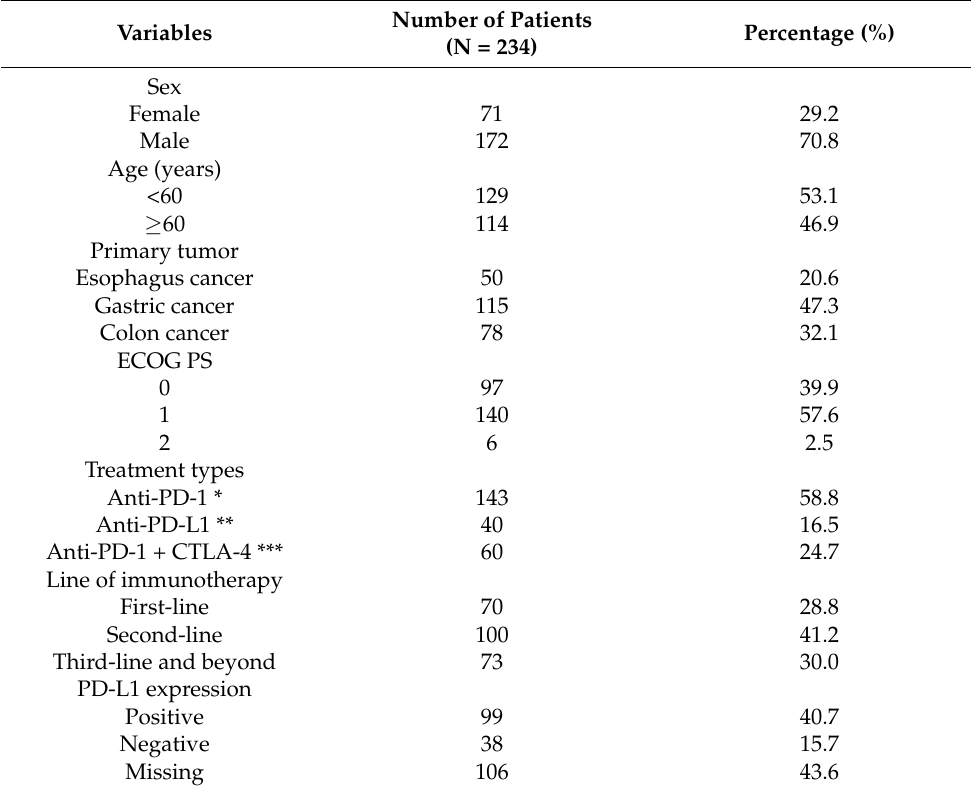
Table 1. Demographic and clinicopathological characteristics of enrolled